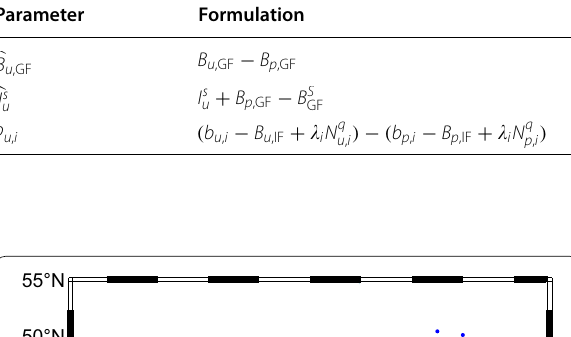
Table 4 The estimable parameters for a PPP–RTK user Parameter Formulation